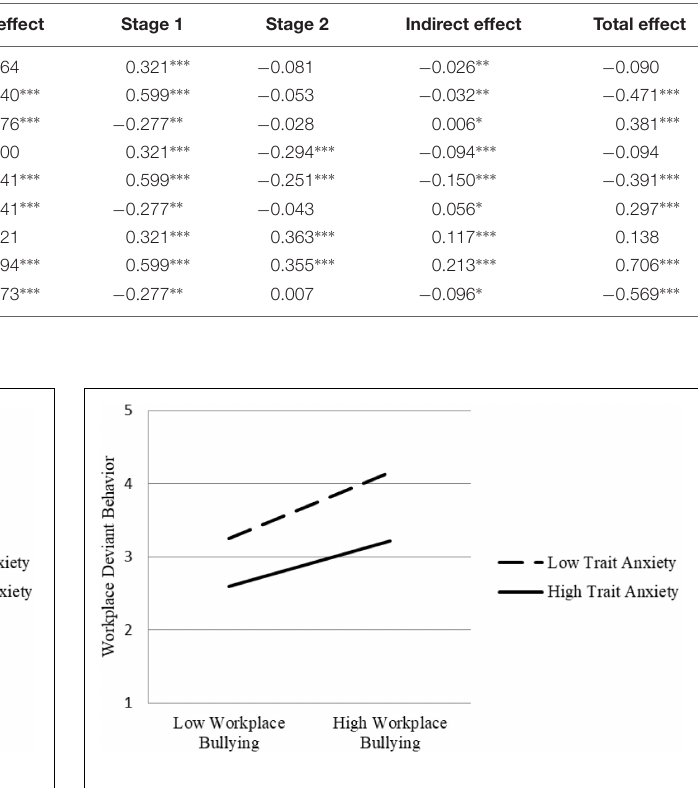
FIGURE 3 | Schematic diagram of interaction effect (organizational citizenship behavior).